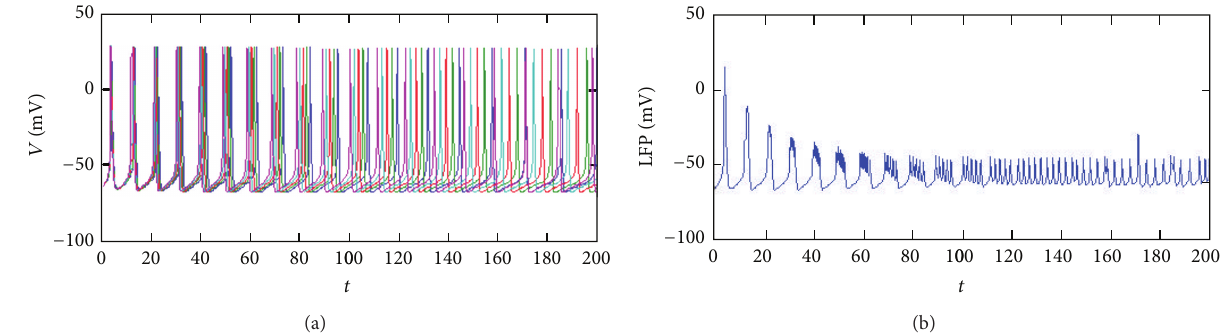
= 0 . (b) LFP of five MCs when 𝑔 GABA